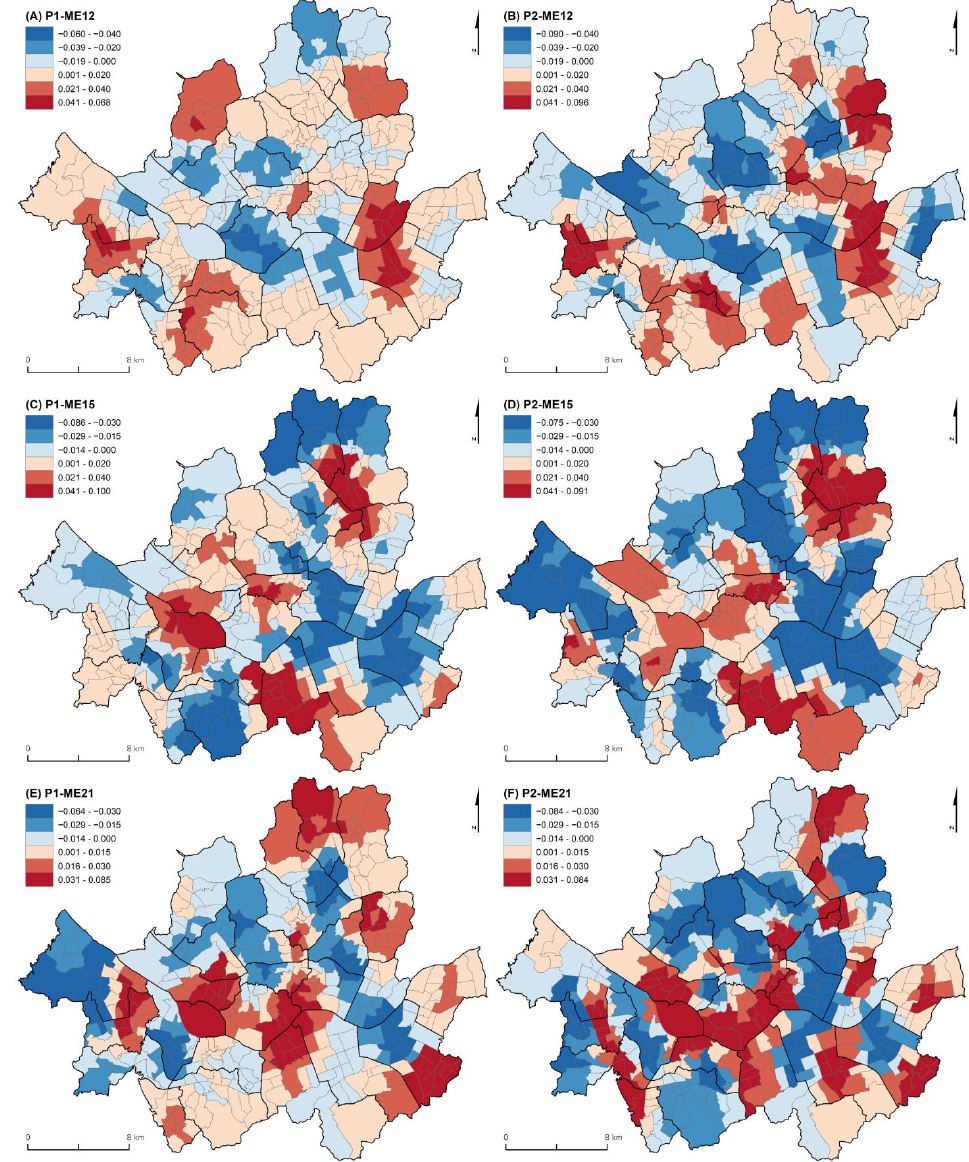
Figure 5. Spatio-temporally varying coefficients of population mobility on weekends; ( A ) ME12 in P1, ( B ) ME12 in P2, ( C ) ME15 in P1, ( D ) ME15 in P2, ( E ) MD21 in P1, and ( F ) MD21 in P2.